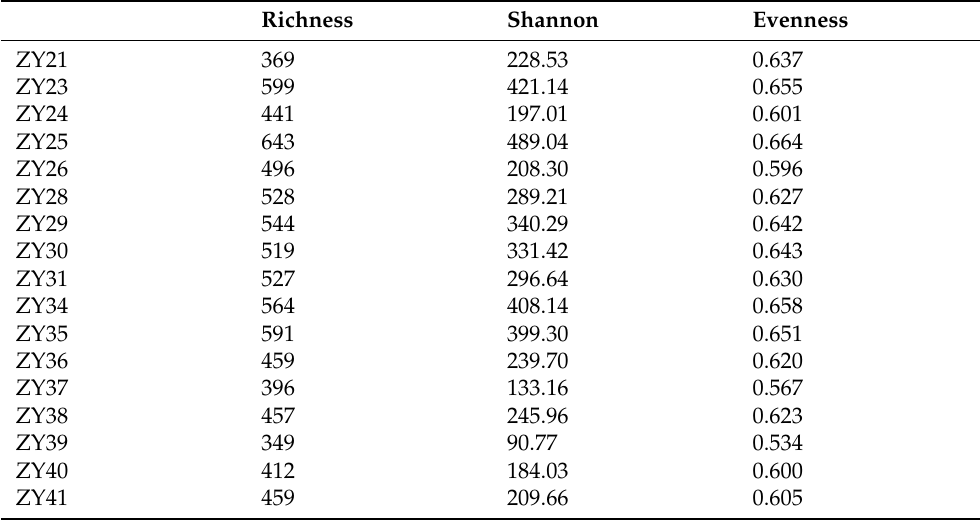
Table 3. Alpha diversity (richness, Shannon and evenness)